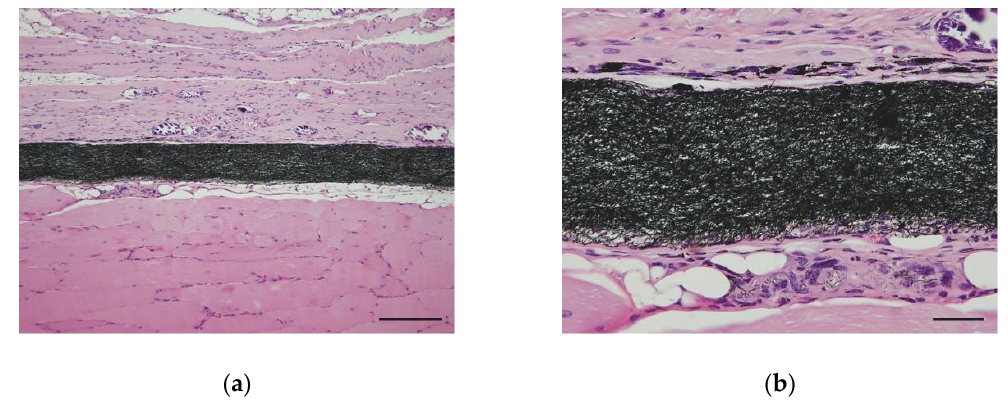
Figure 3. Optical microscope image of a 250 nm type TCFW that was implanted into the back muscle of a mouse for 4 weeks. ( a ) Fibroblasts and macrophages accumulated around the implants in the muscle tissue, forming foreign-body granulomas. No necrosis or strong inflammatory reactions were observed. Scale bar, 100 μm; ( b ) In the high-power field of view, nanofibers phagocytosed by macrophages were observed in the periphery of the implant. Scale bar, 20 μm.